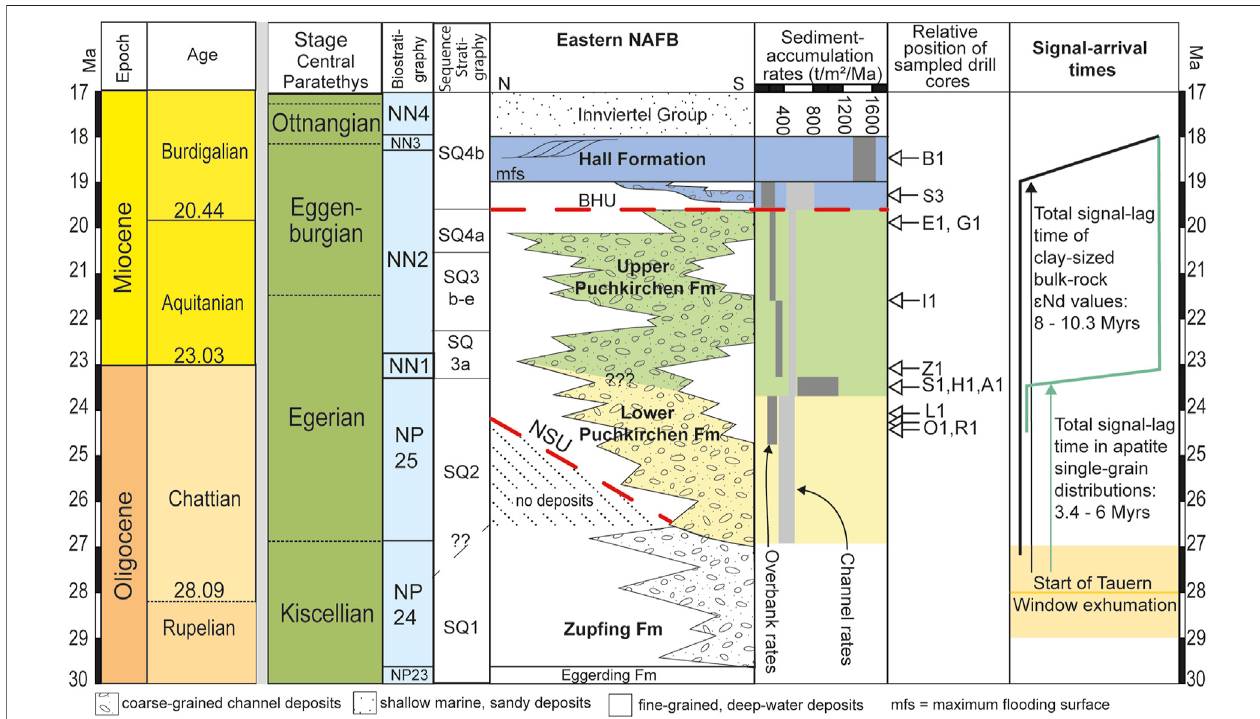
FIGURE 3 | Correlation of the global stratigraphy (Gradstein et al., 2012), the Central Paratethys stratigraphy (Piller et al., 2007), the calcareous nannoplankton zonationscheme(Backmanetal.,2012;Agninietal.,2014),thesequencestratigraphyoftheGermanNAFBeastofMunich(Zweigel,1998),thestratigraphicconceptof the Upper Austrian NAFB and the sediment-accumulation rates on the channel and overbanks following Hülscher et al. (2019). The relative position of the drill cores are projected onto the wells with thestratigraphic information in the area (Hülscher et al., 2021).The signal-arrival times of the changing provenance in responseto the Tauern Window exhumation differ between the methods (bulk-rock vs single-grain analysis) and the grain-size fractions (clay vs sand-sized sediment). See text for discussion. Redrawn after Hülscher et al. (2019).